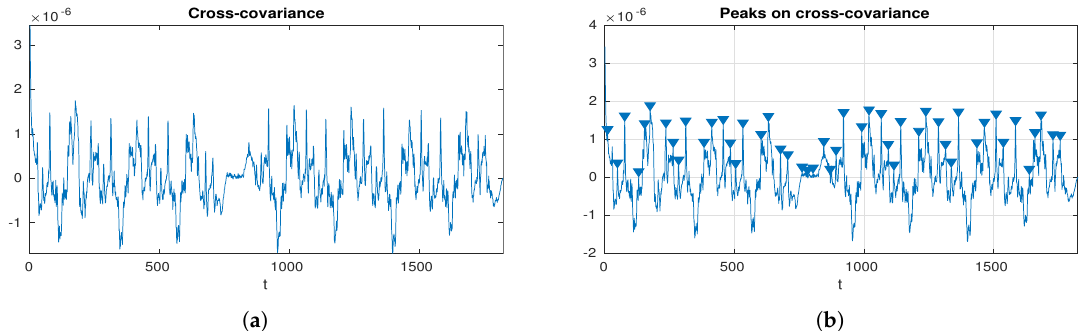
Figure 7. Cross-covariance and peaks. ( a ) Cross-covariance with sliding window; ( b ) Peaks on